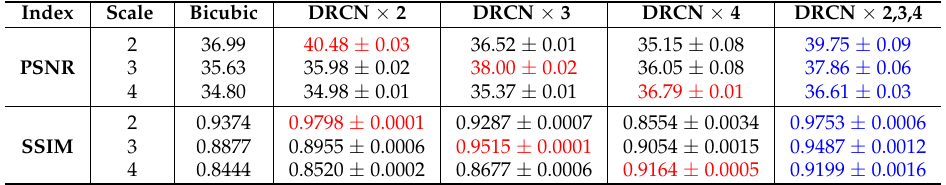
Table 9. Cross-scale experiments of DRCN trained and tested on BUAA-SID 1.0 (mean deviation). The red font indicates the best performance, while the blue font indicates the second best.